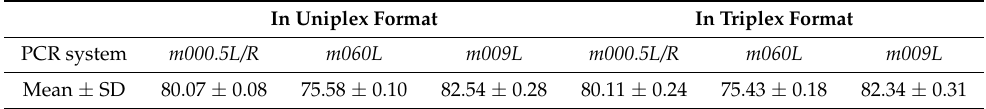
Table 6. Comparison of the melting temperatures obtained for the singleplex and